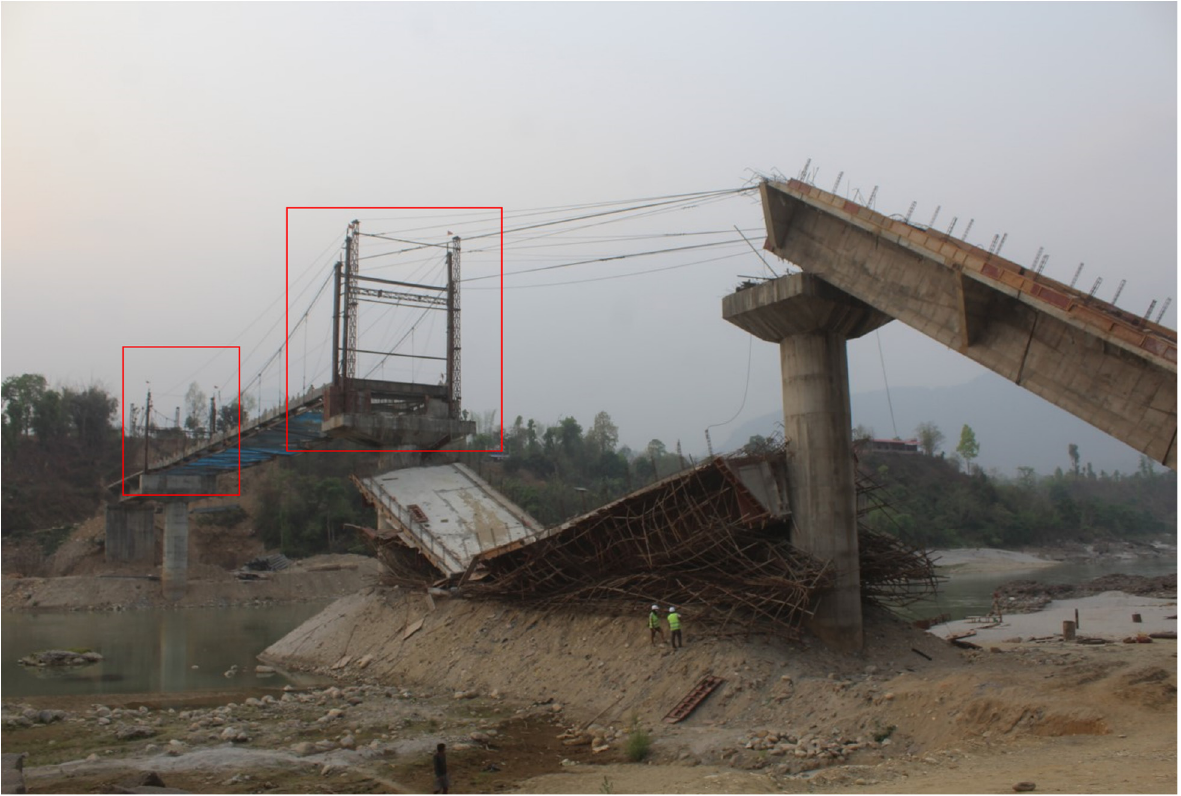
Figure 3. Steel towers constructed on pedestal.